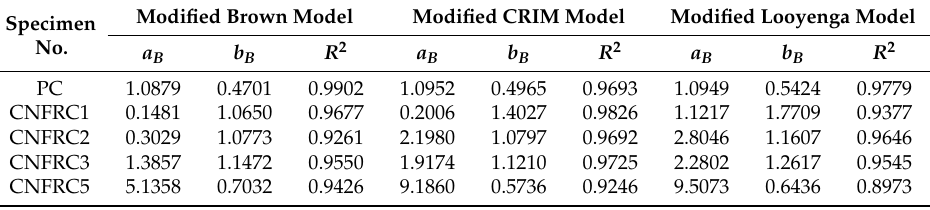
Table 4. Parameter ε „ based on modified models.